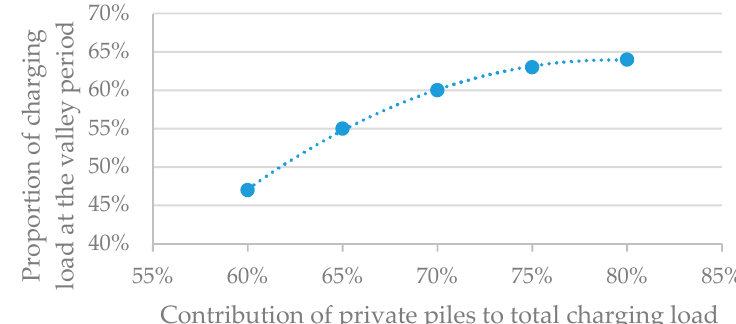
Figure 9. Sensitivity of charging load at the valley period to increasing private charging piles use.